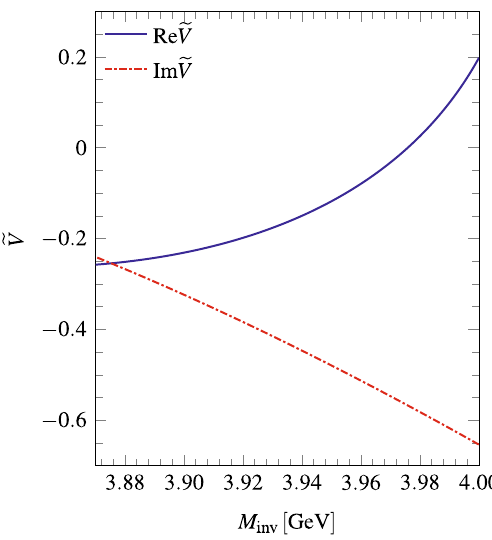
Fig. 6 Real and imaginary parts of triangle loop contribution (cid:17) V (cid:6) given in Eqs. (14) and